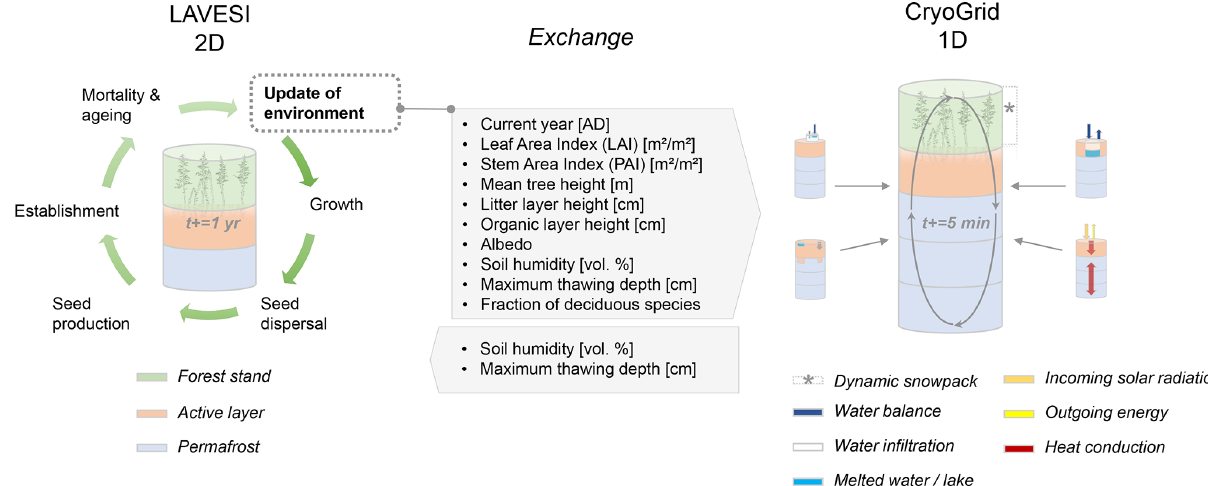
Figure 2. Scheme of coupling CryoGrid and LAVESI as well as the involved processes.